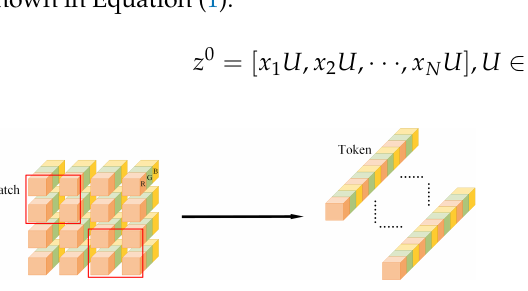
Figure 4. The original image is divided into nonoverlapping Patches(red boxes), and the original spectral features in the Patches are concatenated in the spatial dimension to be output as tokens of the original image. The dotted lines represent the rest of the Tokens that are